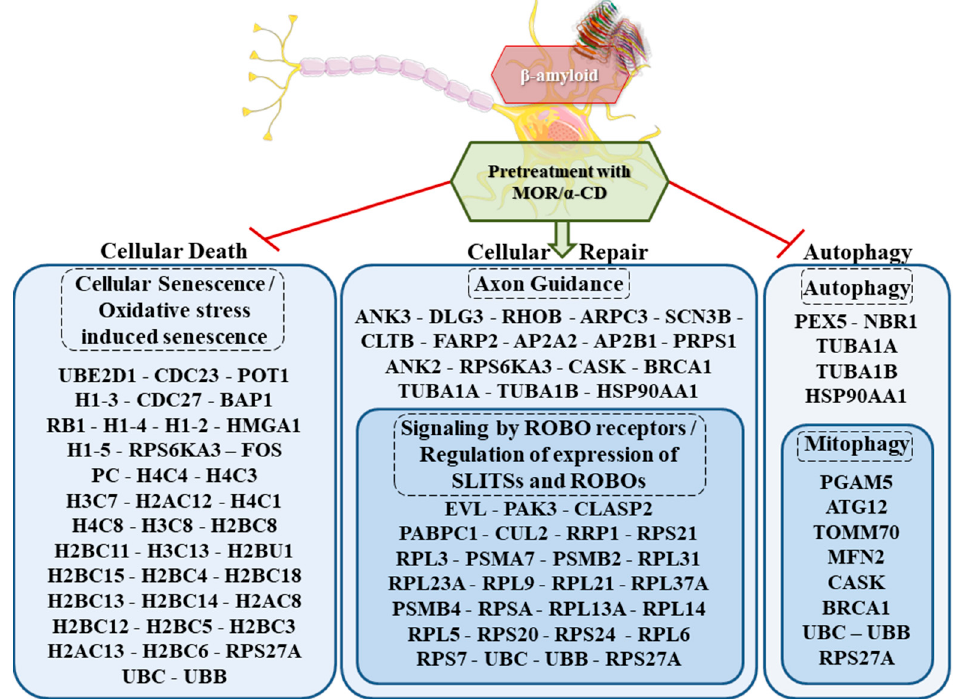
Figure 2. Biological clusters of DEGs activated by MOR/ α -CD action. The analysis of differential expressed genes upregulated between control and A β 1-42 groups revealed 97 genes downregulated in the analysis of A β 1-42 against A β 1-42 -MOR/ α -CD and they are represented in the Figure. They are enriched in Reactome for the pathways "Oxidative stress-induced senescence" and “Senescence” represented in the “Cellular Death” cluster, for “Autophagy” and “Mitophagy” in the “Autophagy” one. The downregulation of the genes in these pathways highlights the inhibitor effects of MOR/ α -CD. On the other hand, the downregulation of the genes in the “Cellular Repair” cluster with “Regulation of expression of SLITs and ROBOs”, “Signaling by ROBO receptors” and “Axon Guidance” showed the increased effect of synaptic plasticity. The β -amyloid structure (6Y1A) was retrieved by PDB. The figure was drawn using the vector image bank of Servier Medical